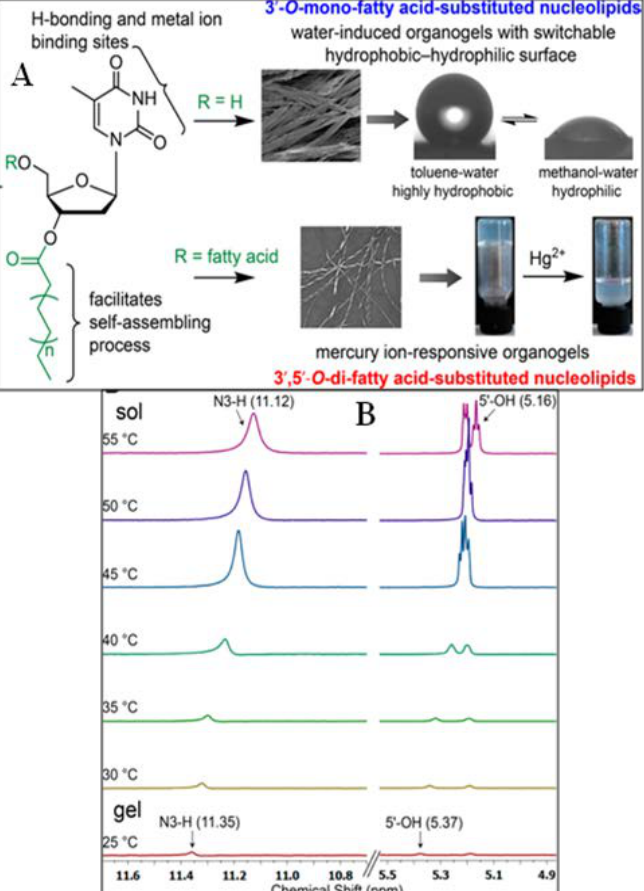
Figure 25. ( A ) Design of self-assembling thymidine nucleolipids, which show different gelation behavior, morphology, surface tunability, and metal-ion responsiveness depending on the site of attachment of the fatty acid acyl chain onto the sugar residue. Water induces the supramolecular gelation of 3 ′ - O -monofatty acid-substituted nucleolipids dispersed in organic solvents. The surface of the xerogel films could be tuned between highly hydrophobic and hydrophilic states using an appropriate organic solvent-water mixture. 3 ′ ,5 ′ - O -Difatty acid-substituted nucleolipids form organogels, which is highly responsive to the presence of Hg 2+ ions; ( B ) 1H NMR spectra of a 3 ′ -stearoyl derived glycolipid gel (partial gel, d6-DMSO-water = 95:5) at its CGC as a function of increasing temperature. N3-H and 5 ′ -OH atoms exhibited a discernible upfield shift in their proton signals during gel to sol transition. Reprinted with permission from [104]. Copyright 2016 American Chemical Society.